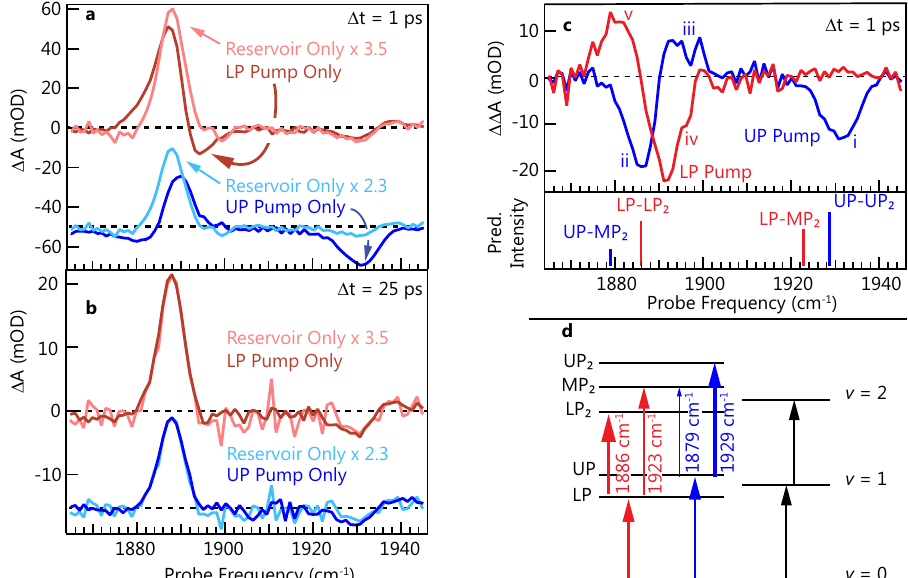
Fig. 4 Scaled reservoir and subtracted reservoir spectra and theoretical predictions of transitions of cavity-coupled SNP. a Pump – probe spectra obtained with spectrally fi ltered pump pulses reported in terms of − log( T / T 0 ). The dark red trace is the transient spectrum recorded 1 ps after exciting with the LP Pump mask and the light red trace is the spectrum recorded 1 ps after exciting with the Reservoir-Pump mask then multiplied by 3.5, as described in the text. The blue traces (offset for clarity) are the corresponding spectra for UP Pump mask excitation, for which the scaling factor is 2.3. Rabi splitting is 46.5 cm − 1 . b Pump – probe spectra obtained as described in a , but with a time delay of 25 ps. The scaled Reservoir-Pump spectra (light red, light blue) overlap the UP Pump (dark blue) and LP Pump (dark red) spectra. c Subtracted spectra for UP Pump (blue) and LP Pump (red) excitation. The positive and negative feature frequencies are marked as follows: i = 1932 cm − 1 , ii = 1886 cm − 1 , iii = 1892 cm − 1 , iv = 1892 cm − 1 , and v = 1883 cm − 1 . The stick spectra correspond to the predicted transition frequencies from the LP (red) and UP (blue) to the second excited polariton manifold, with the relative heights proportional to their predicted intensities. d Schematic polariton level diagram up to the second excited manifold. Vertical arrows indicate the dominant polariton transitions with the corresponding transition frequencies in cm − 1 . The size of the arrowhead is roughly proportional to predicted transition